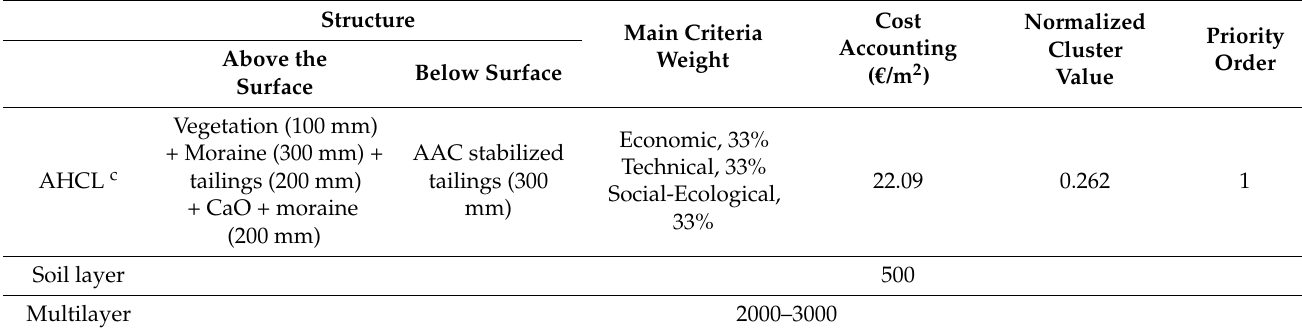
Table 1. Cont. Structure